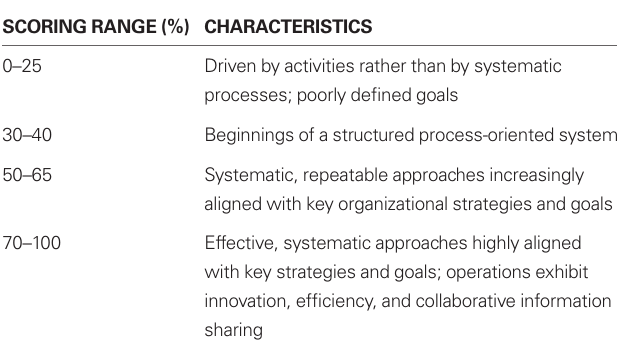
Table 3 | Process scoring (categories 1–6).